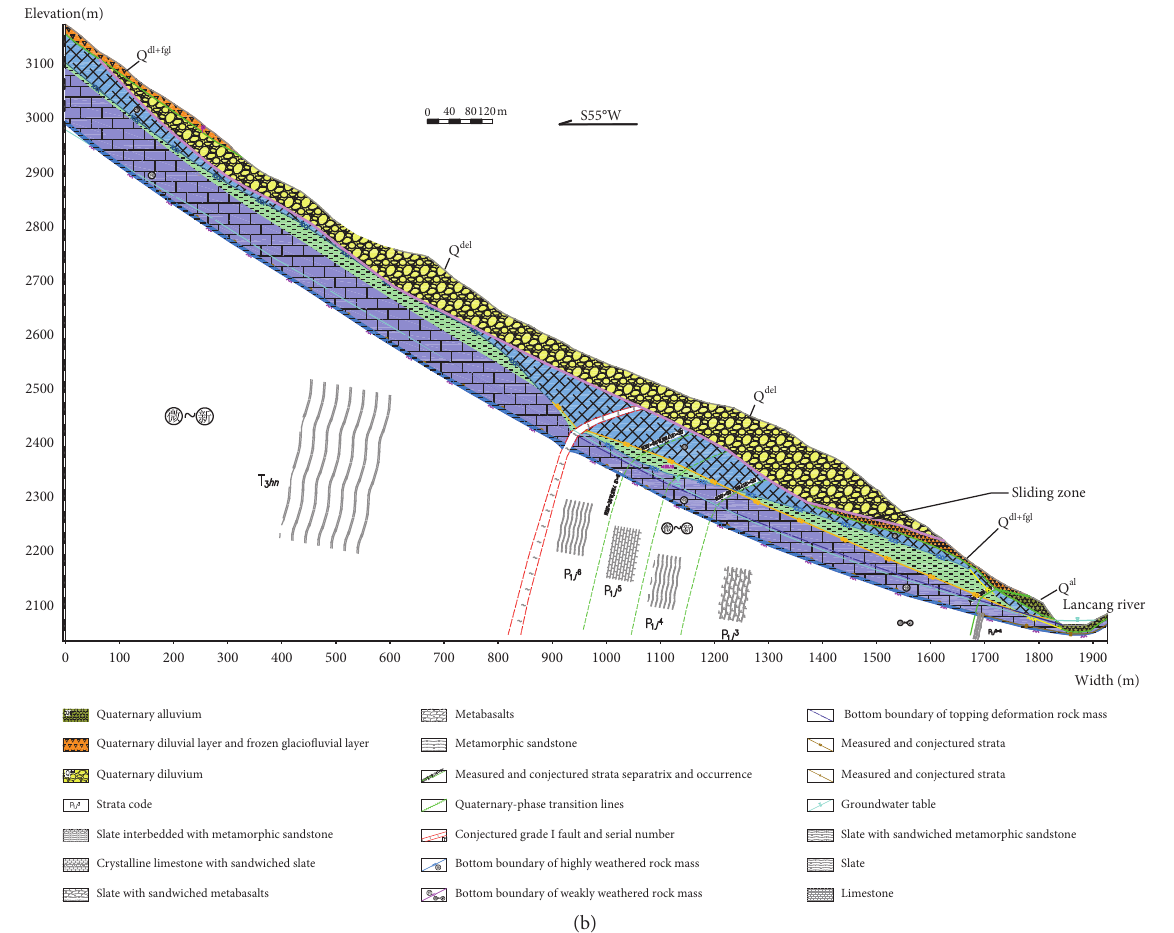
Figure 4: Engineering geologic profiles of the Zhenggang landslide. (a) Profile A-A’ in zone I. (b) Profile B-B’ in zone